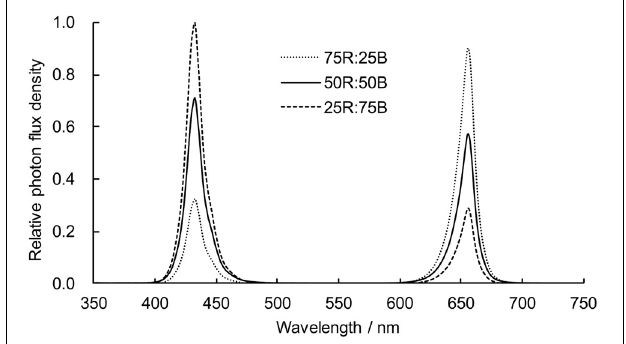
FIGURE 1 | Light spectra of light